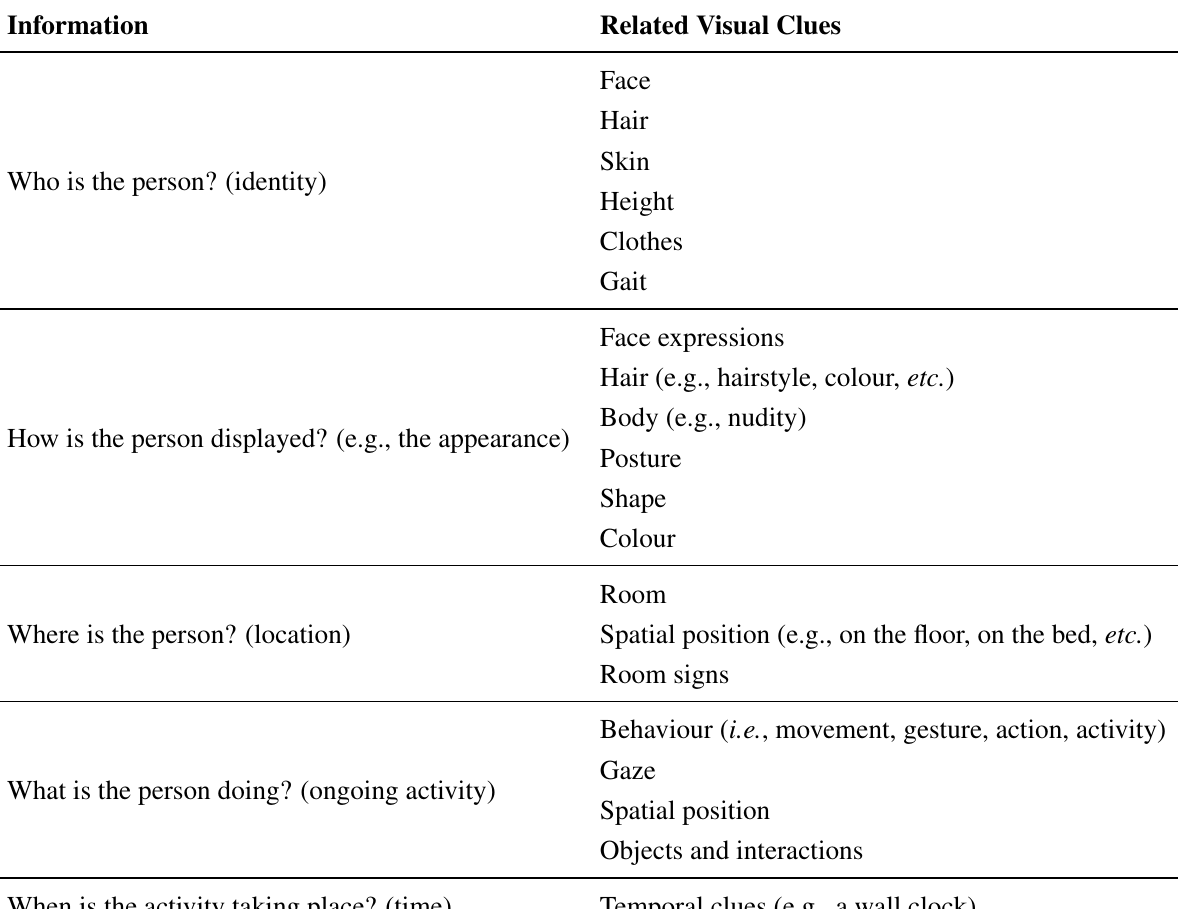
Table 2. The types of information that can be extracted out of image sequences and the related visual clues that can provide this